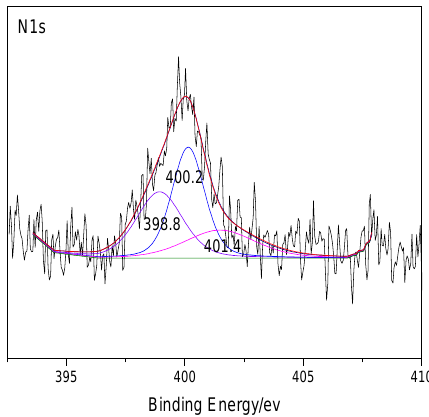
Figure 2. XPS N 1s spectrum of Bulianta coal. Table 5. XPS O 1s and N 1s data of the Bulianta coal sample.